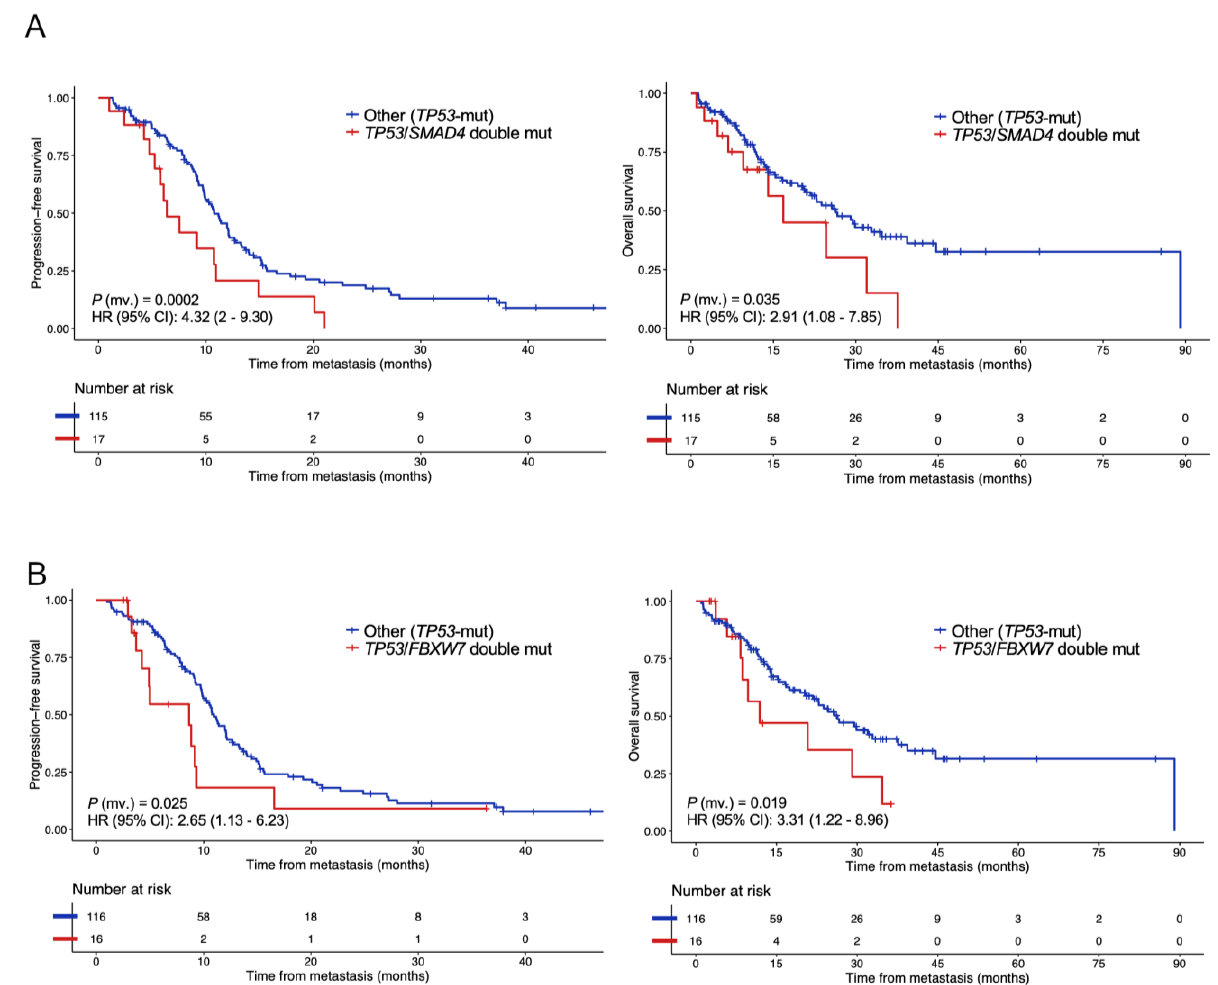
Figure 2. Prognostic value of double mutations in TP53 / SMAD4 and TP53 / FBXW7 in metastatic colorectal cancer patients. Kaplan–Meier estimates displaying the cumulative proportion of individuals ( Y – axis) who were progression – or death – free over the study period ( X – axis), and Cox – derived resulting statistics for PFS and OS in the study population (N = 132/200, 66%) analyzed with the Oncomine panel – based sequencing, stratifying by the presence or absence of coexistent mutations in ( A ) TP53 / SMAD4 and ( B ) TP53 / FBXW7 . p – values were obtained using the log – rank test and hazard ratios using a Cox proportional hazards model, correcting for baseline clinical factors (see Methods). mv., multivariable.